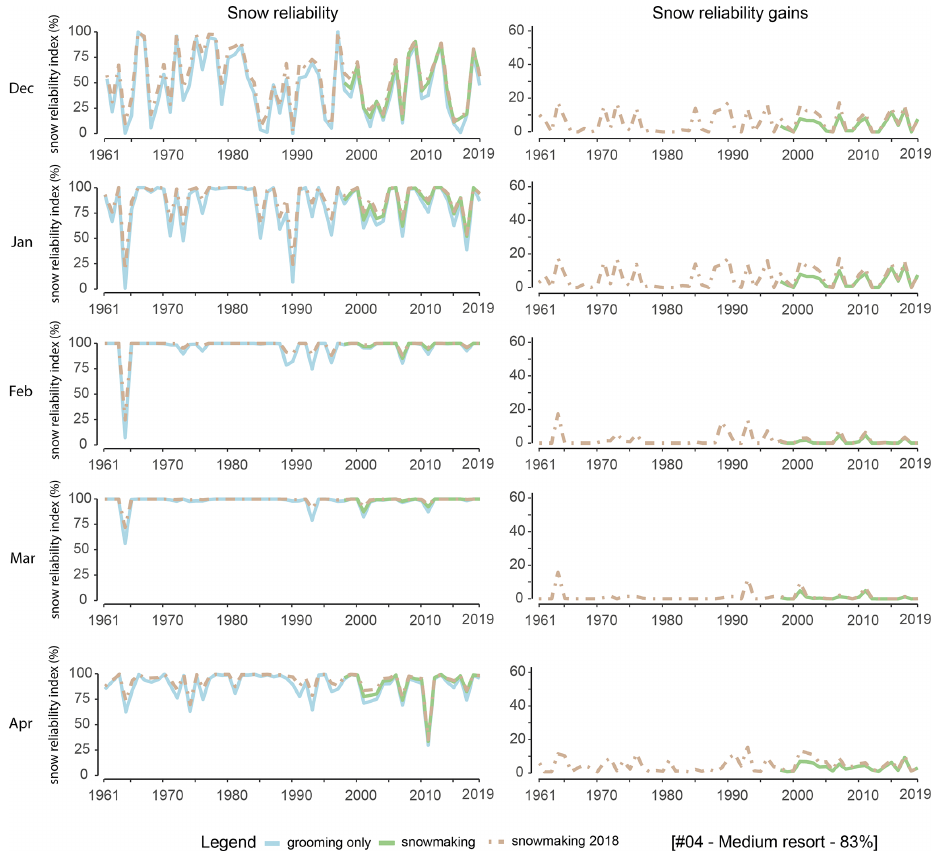
Figure 5. Time evolution of the combined snow reliability indicator and snowmaking fractional coverage for ski resort no. 4 (medium size, 83% of its surface area below 2000m elevation) from 1961 to 2019. The left column represents the time variations in the indicator for several snow management options (grooming only, individual evolution of the snowmaking coverage based on investment figures and the situation corresponding to using the snowmaking coverage in 2018 for the whole time period). The right column represents the increase in snow cover reliability compared to the grooming-only situation (taking into account the evolution in snowmaking coverage since 1997 or using the fractional coverage for 2018 throughout the entire record). Each row corresponds to a monthly snow reliability indicator: December to April.